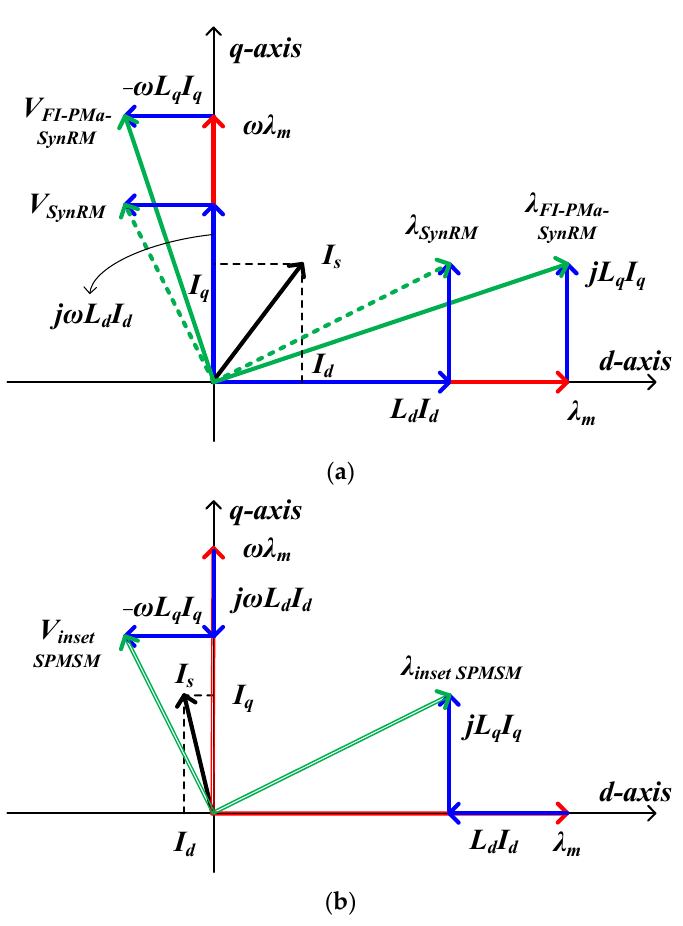
Figure 2. Phasor diagrams: ( a ) FI-PMa-SynRM and SynRM; ( b ) Inset SPMSM.